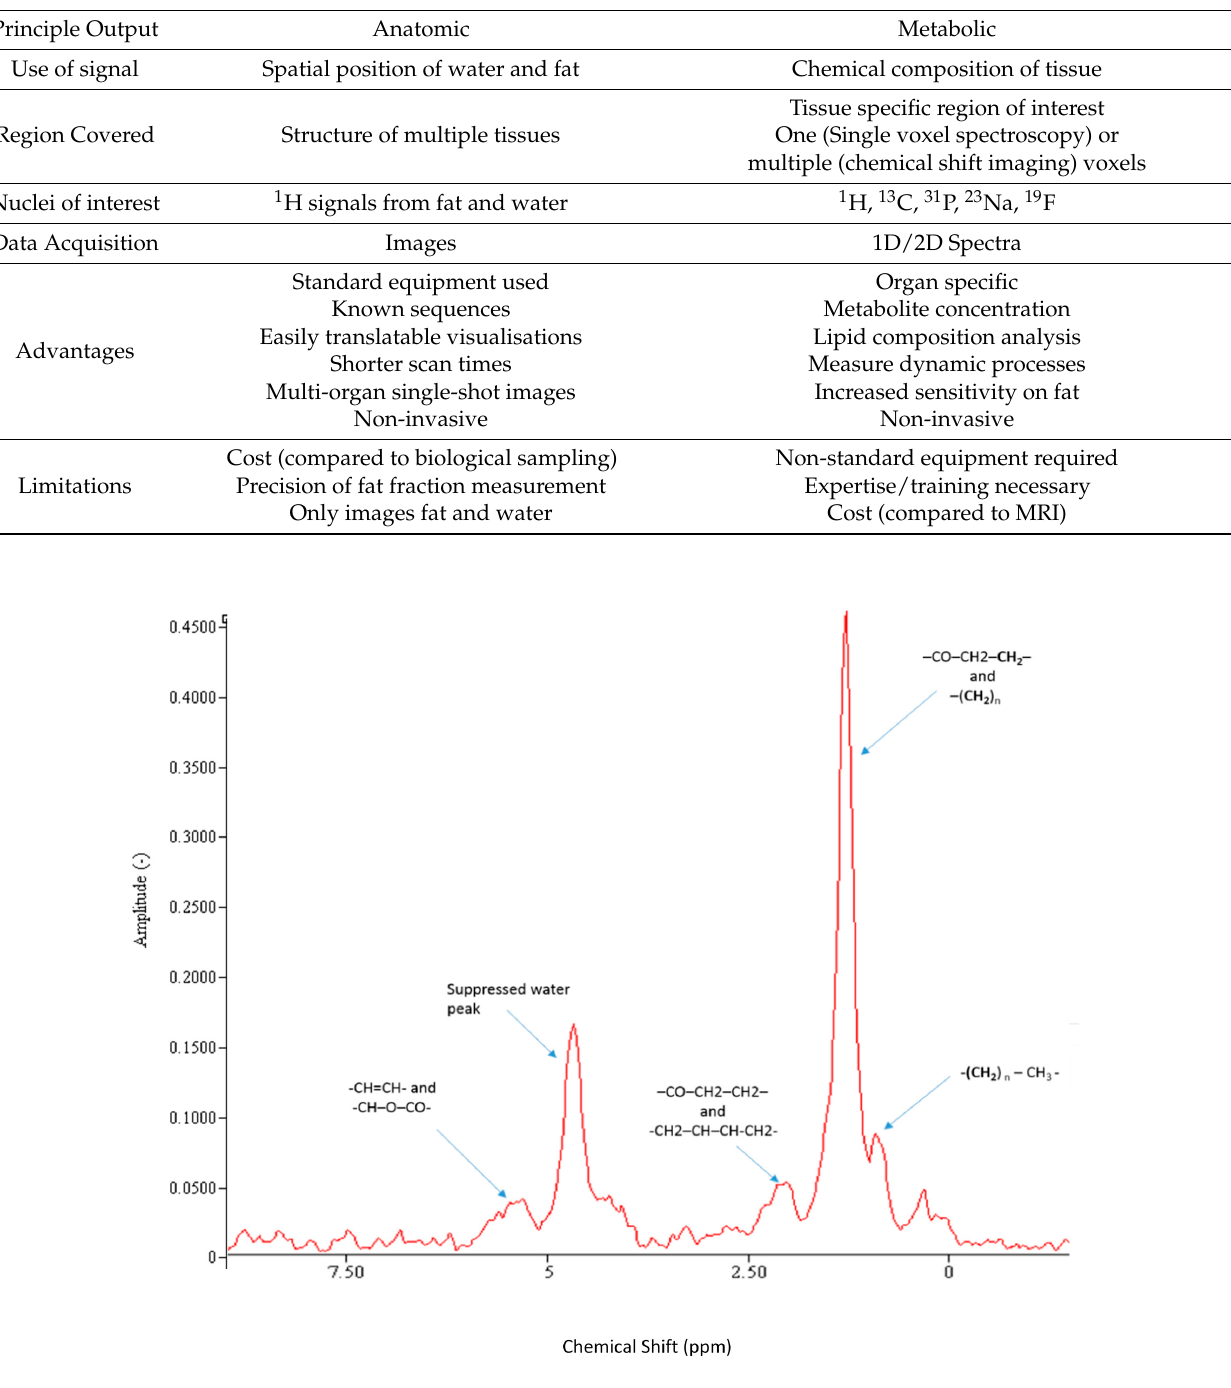
Figure 3. Liver 1 H MR Spectrum (3T) with water suppression acquired in vivo from an individual with NAFLD. The different fat peaks resolvable by spectroscopy at 3T are shown. CH=CH (olefinic acid), CH-O-CO (glycerol), CO-CH 2 -CH 2 ( α carboxyl), CH 2 -CH=CH-CH 2 ( α olefinic), CO-CH 2 -CH 2 ( β carboxyl), (CH 2 )n (methylene), (CH2)n-CH 3 (methyl). Spectral resolution at 3T is excellent, allowing for accurate fitting and quantification of IHTG. The fat fraction is derived from dividing the fat content by the combination of fat and water content.